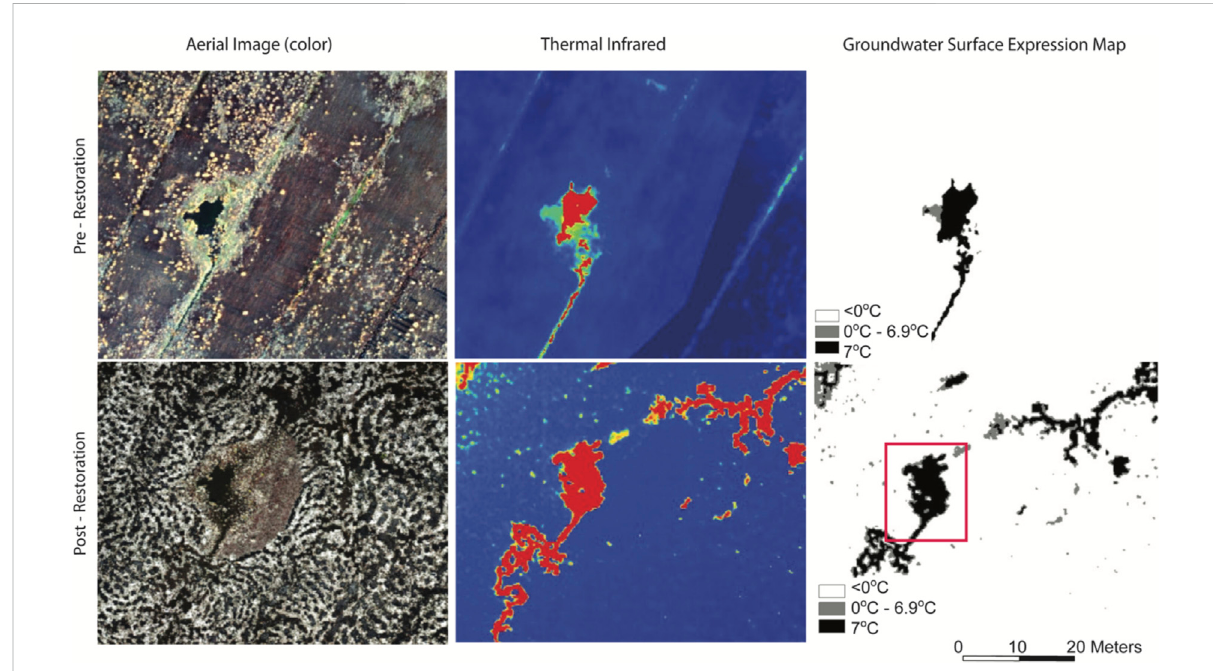
FIGURE 9 Comparative UAS imagery from pre-restoration (top row) to post-restoration at Foothills Preserve, from left to right: (left) plain light (RGB image), (center) thermal infrared, and (right) surface expression of groundwater (black = groundwater and gray = mixing zone). This fi gure shows a smallareainthenortheastpartofFoothillsPreservethatwasnotalteredduringrestoration.Here,the fl owintoandoutofthisareareverseddirection as a result of new interconnected fl owpaths generated during